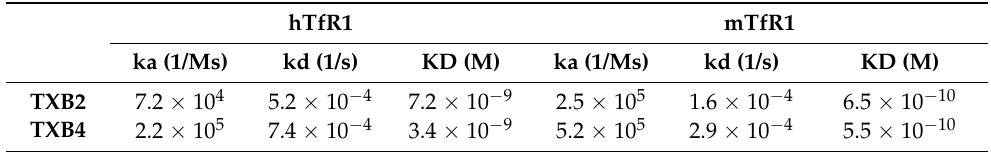
Table 1. Binding kinetics of TXB2 and TXB4 to hTfR1 and mTfR1. To determine binding kinetic properties, a multicycle SPR analysis was performed using